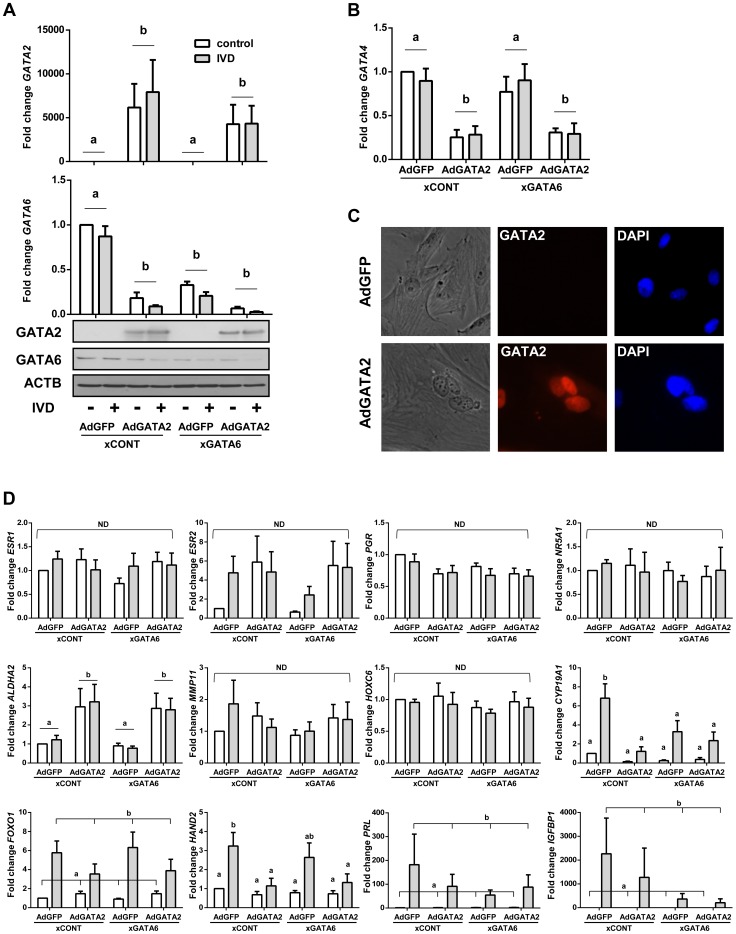
The effect of silencing GATA6 and expressing GATA2 in OSIS.(A) Manipulating GATA expression in OSIS was accomplished using adenoviral transduction to express GATA2 (AdGATA2) and siRNAs targeting human GATA6 (xGATA6). Transduction resulted in significant mRNA (top) and immunoreactive GATA2 (bottom) relative to cells transduced with an adenovirus expressing GFP. Compared to control siRNAs, xGATA6 effectively silenced GATA6 mRNA (qPCR; middle), and protein (immunoblot; bottom). IVD did not significantly affect the expression of any of the GATAs examined, but AdGATA2 strongly repressed (A) GATA6 and (B) GATA4. (C) Phase contrast (left), immunofluorescence for GATA2 (red), and DAPI staining (right) shows nuclear GATA2 protein in AdGATA2-transduced cells. (C) qPCR was performed on the same panel of 12 genes shown in Figure 1. AdGATA2 was the main effect for the observed increase in ALDH1A2, while xGATA6 and AdGATA2 both repressed CYP19A1. IVD was the main effect for FOXO1, HAND2, PRL, and IGFBP. The ESR1, ESR2, PGR, NR5A1, HOXC6 and MMP11 were not significantly affected by any of the treatments. (n = 6; connecting bars show main effect p<0.05 by 2-way ANOVA; lower case letters indicate significantly different groups p<0.05 by Tukey's after ANOVA).